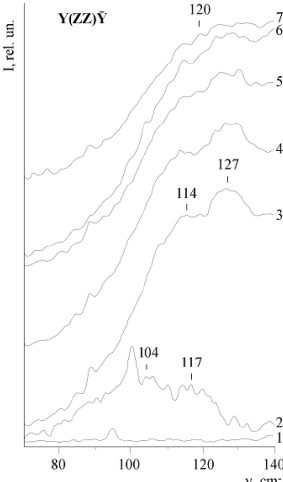
Figure 26. Fragments of the Raman spectra of crystals SLN (1), CLN (2), LiNbO 3 :Zn, [Zn, mol. %] = 0.03 (3); 0.05 (4); 0.94 (5); 1.12 (6) and 1.59 (7) in the two-particle states of acoustic phonons area. The figure is reproduced with the permission of Pleiades Publishing, Ltd. from the paper Opt. Spectrosc. 2014, V. 116, P. 281-290. doi: 10.1134/S0030400X14010202.